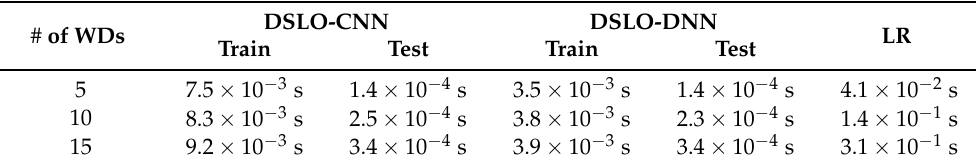
Table 4. Comparisons of CPU execution latency.